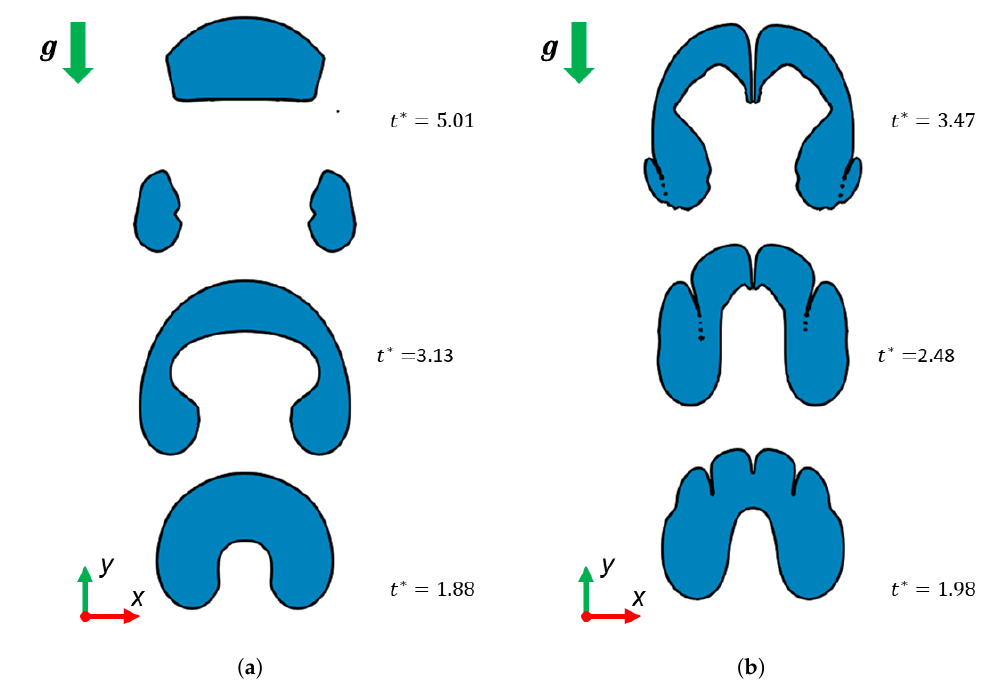
Figure 17. B4 ( a ) and B5 ( b ) He bubbles in PbLi represented through contour r α =